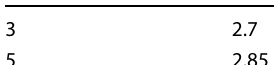
Table 3 pH monitor of AMR degradation by